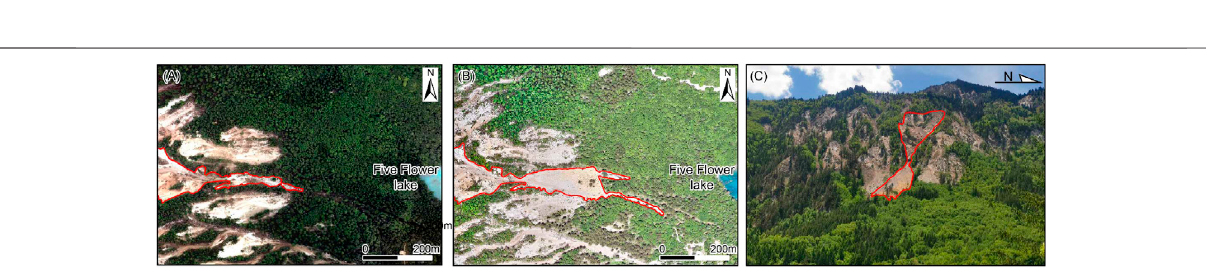
FIGURE8| Expansionofcoseismic landslide (A) Coseismic landslidein2017 (B) Expansion ofcoseismiclandslidein 2020 (C) Field photo showing theexpansion of coseismic landslide.